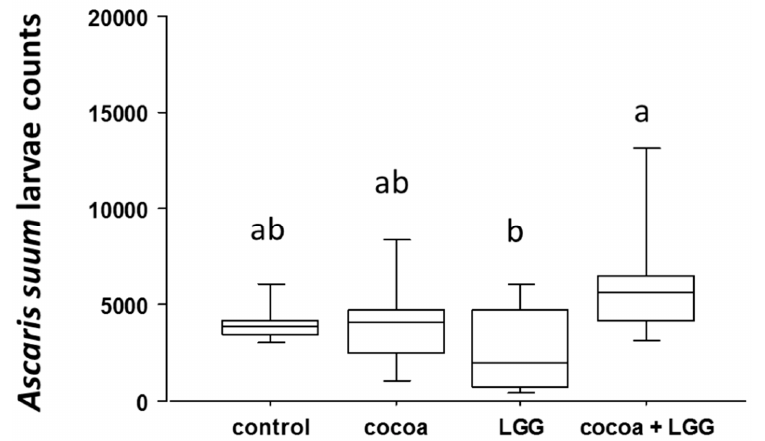
Figure 1. Ascaris suum fourth-stage larvae (L4) from intestinal luminal contents 17 days post-inoculation. Data represent mean larvae counts ± SEM ( n = 8 per treatment). Different letters denote differences among treatments after ANOVA ( p < 0.05).